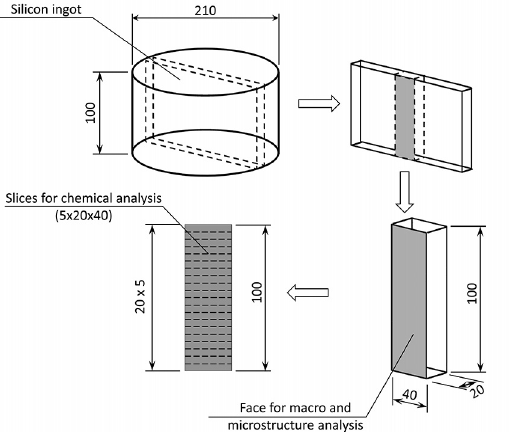
Figure 2. Scheme of sample definition for macro and microstructure examination and for chemical analysis (dimensions in mm). and finally colloidal silica. After examining the macro and microstructure, the slice was cut in 20 pieces of 5 mm height (Figure 2). Eight of these pieces were chosen (based on their microstructure) for chemical analysis by inductively coupled plasma mass spectrometry